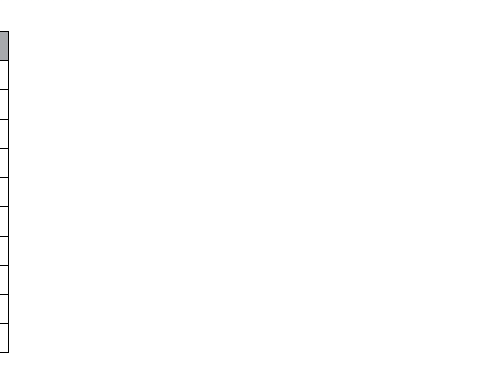
Table 1. Impact matrix of SCL level for possible configuration of the predictors from Model